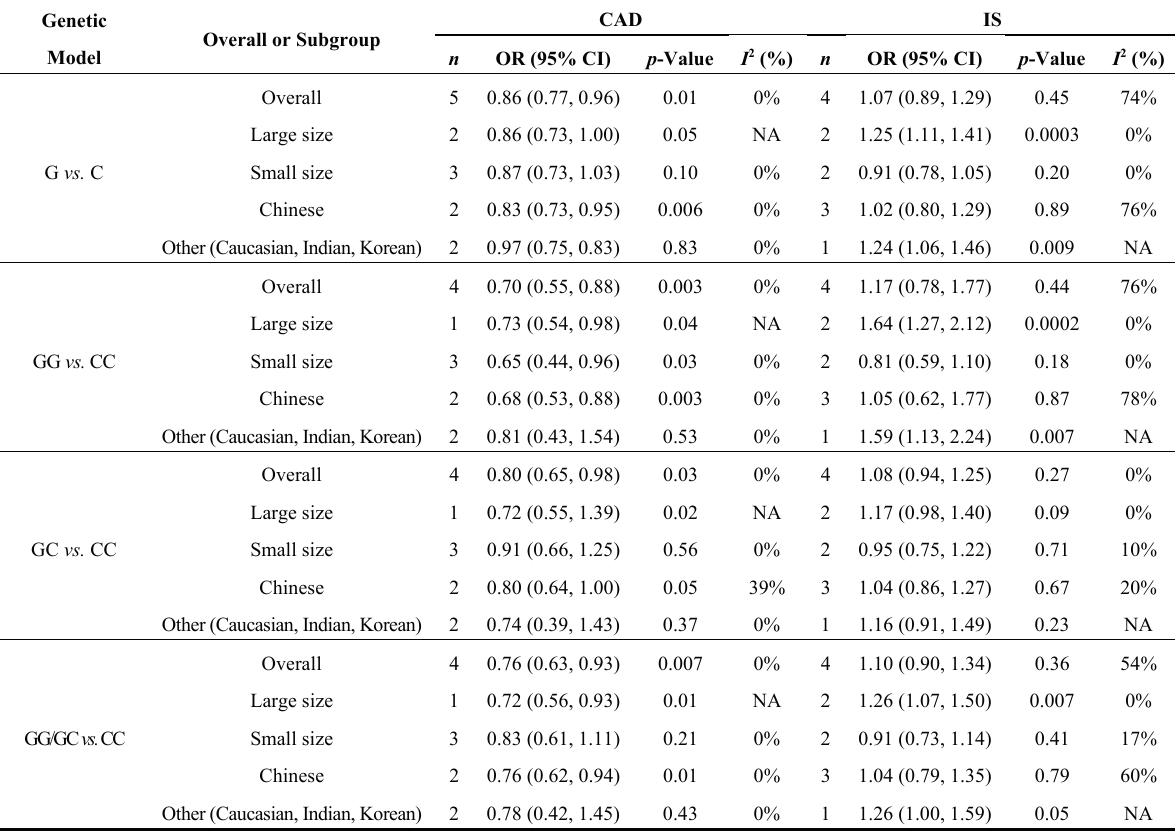
Table 2. Pooled ORs and 95% CIs of the association between miR-146a (rs2910164) and coronary artery disease (CAD) and ischemic stroke (IS).